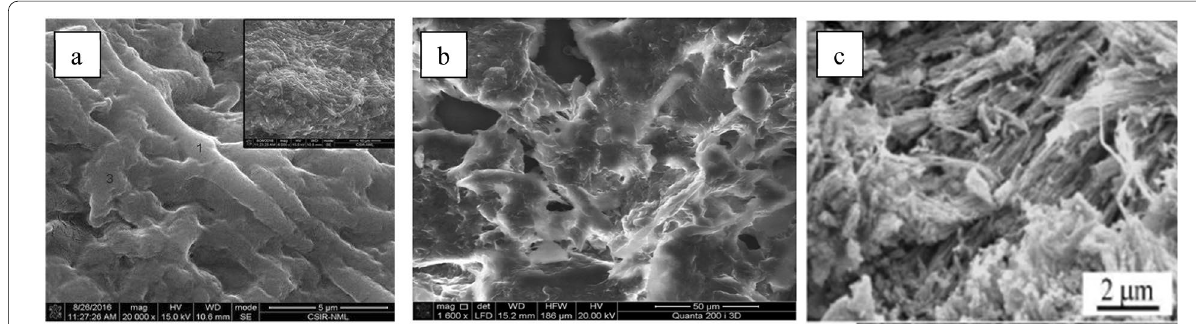
Fig. 2 SEM images of a surface of heat dried fungus A. malaysianum biomass (Majumder et al. 2017), b dried flake of bacterial cellulose ( Gluconacetobacter sucrofermentans ) (Atykyan et al. 2020), (c) crab shell powder (Cai et al. 2019)